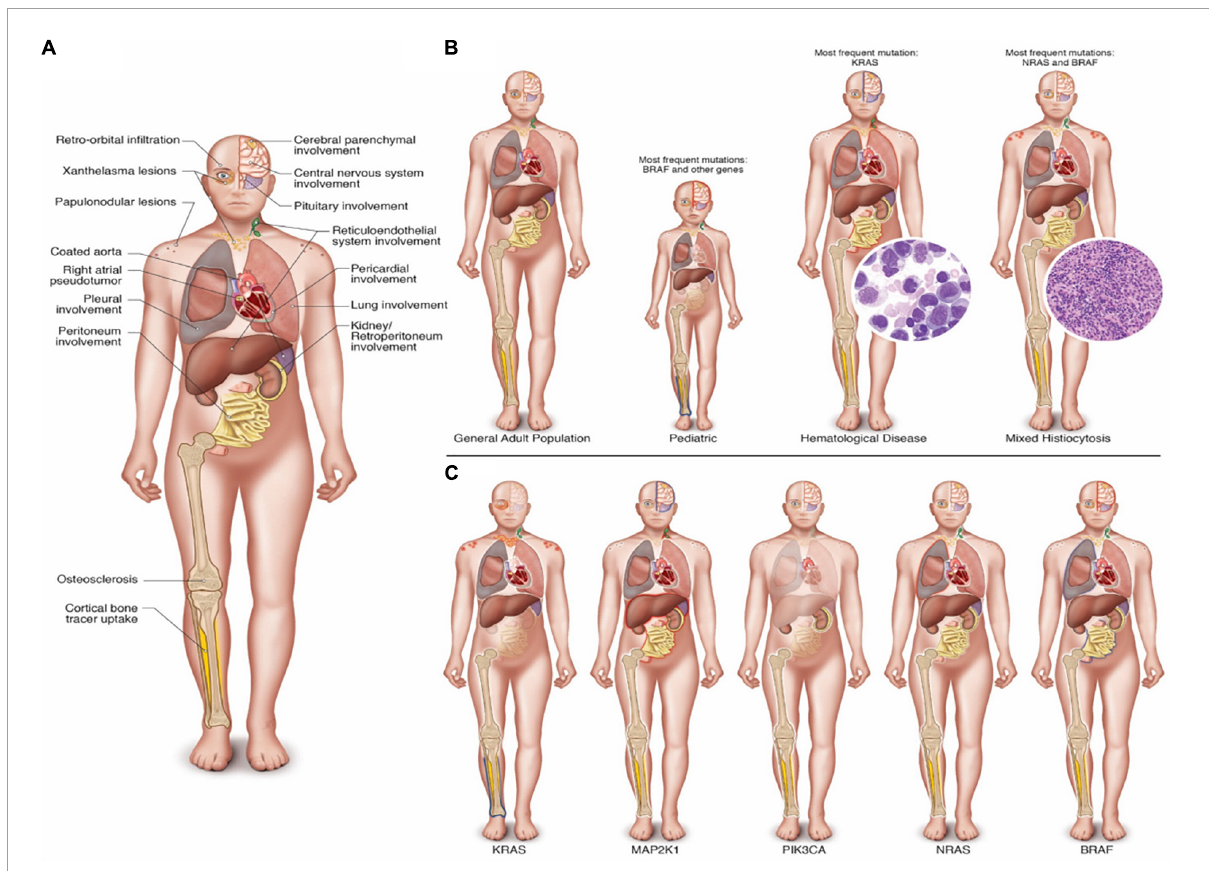
FIGURE2 (Central Illustration): (A) Main clinical and radiographic findings in ECD. (B) Clinical and radiographic findings in specific subgroups of ECD. Characteristics of the general adult population, the pediatric population, patients with associated hematologic disorder, in mixed histiocytosis and the respective most frequently associated genetic mutations reported in the literature. (C) Clinical and radiographic findings of ECD in patients with mutation of KRAS, MAP2K1, PIK3CA, NRAS, and BRAF. Note: In (B,C) , clinical and radiological features of the specific subgroups were depicted transparent if they were never reported in the literature. Instead, they were reported with a blue halo if there was a statistically significant low frequency involvement; a white halo if there was a normal frequency involvement; and finally with a red halo if there was a statistically significant common involvement in the respective